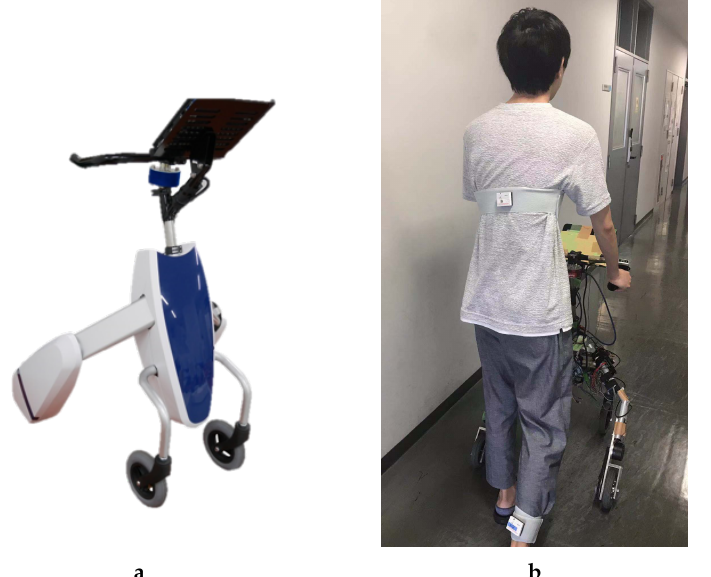
Figure 1. Photograph of ( a ) the robotic walker provided by Panasonic Co., Japan and ( b ) walking experiment.